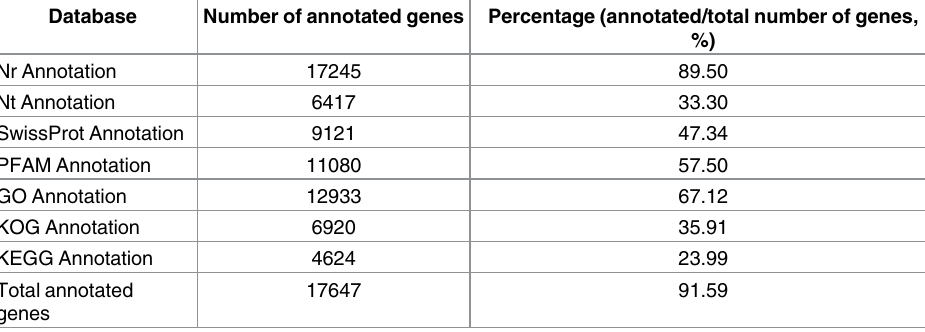
Table 2. Overview of functional annotation of the P . litchii transcriptome.